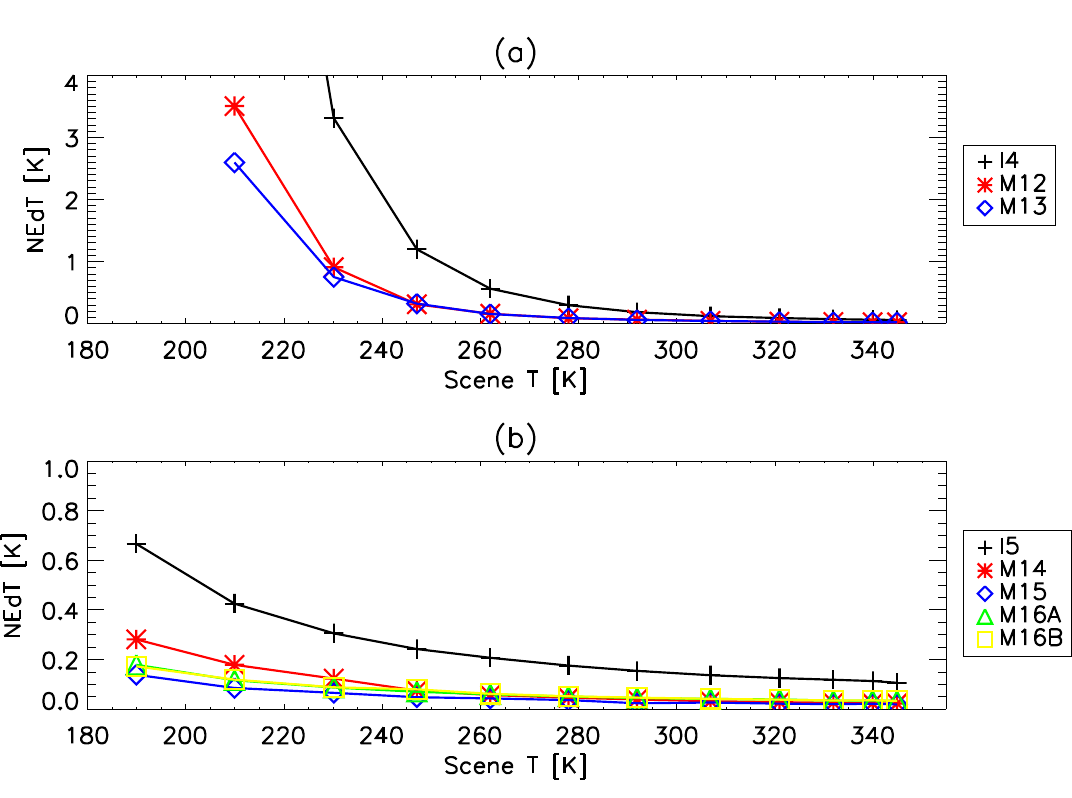
Figure 4. Plots show the measured NEdT as a function of scene temperature for the MWIR bands ( a ) and for the LWIR bands ( b ). Measured data was taken from nominal plateau, HAM side A, electronics side A, FPA temperature 80.5 K using detector 9.